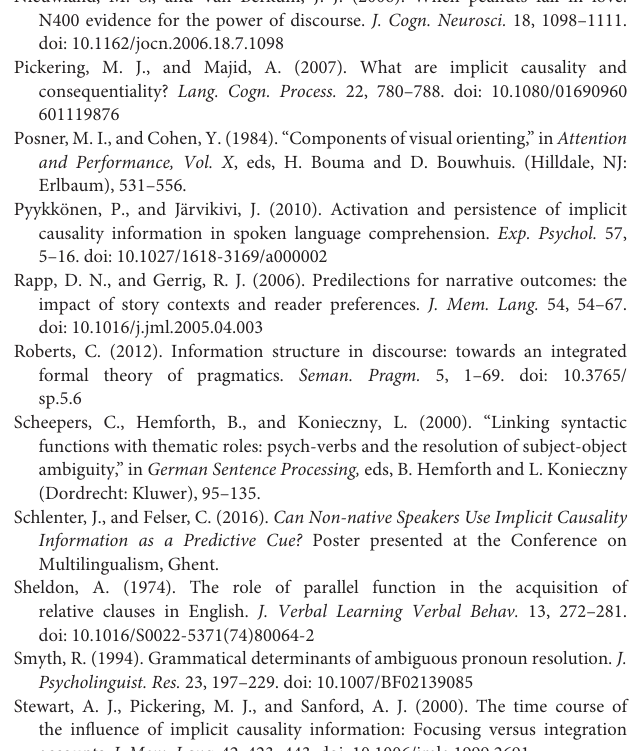
referential processing and the facilitative role of contrastive accent. J. Psycholinguist. Res. 44, 623–650. doi: